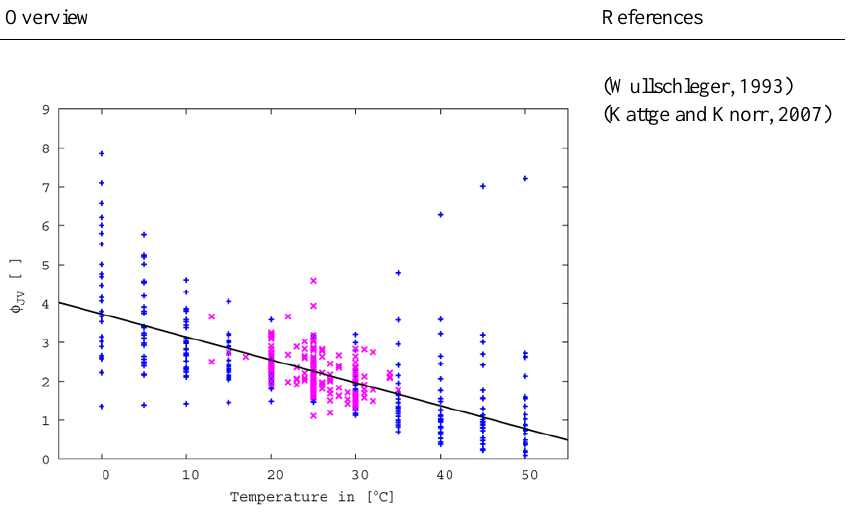
Fig. B13. Ratio of J max to V C,max , φ JV (black line) as a function of temperature. The magenta data points are taken from the study of Wullschleger (1993), while the blue points are derived by the equations used in Kattge and Knorr (2007).